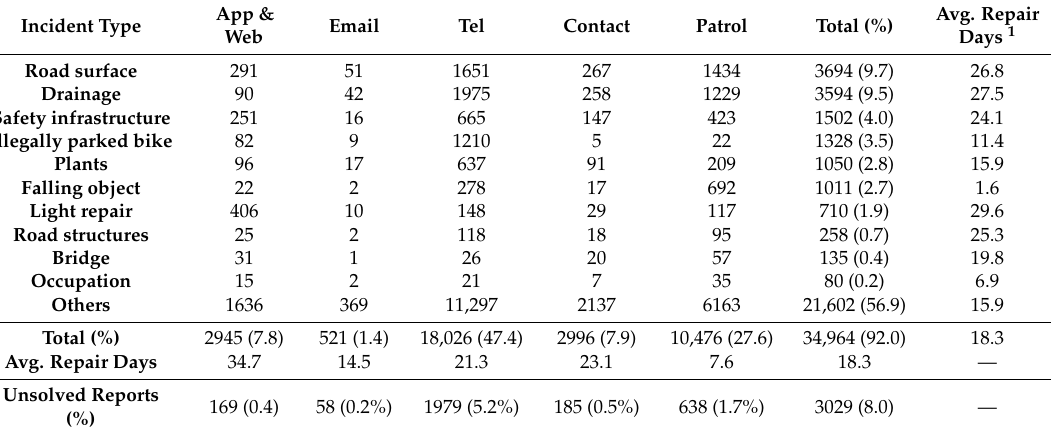
Table 2. Top 10 reported road issues and average repair periods (N =